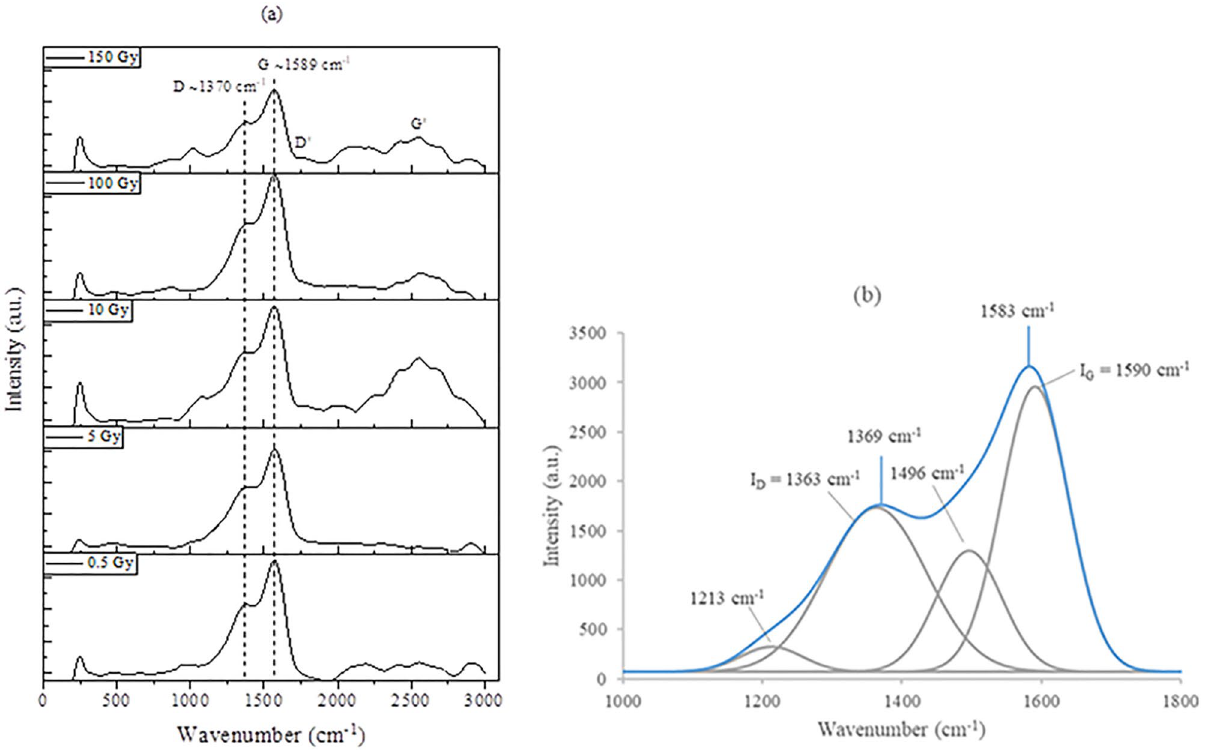
60 Co γ -rays. ( b ) 1 for a dose of 0.5 Gy, revealing four